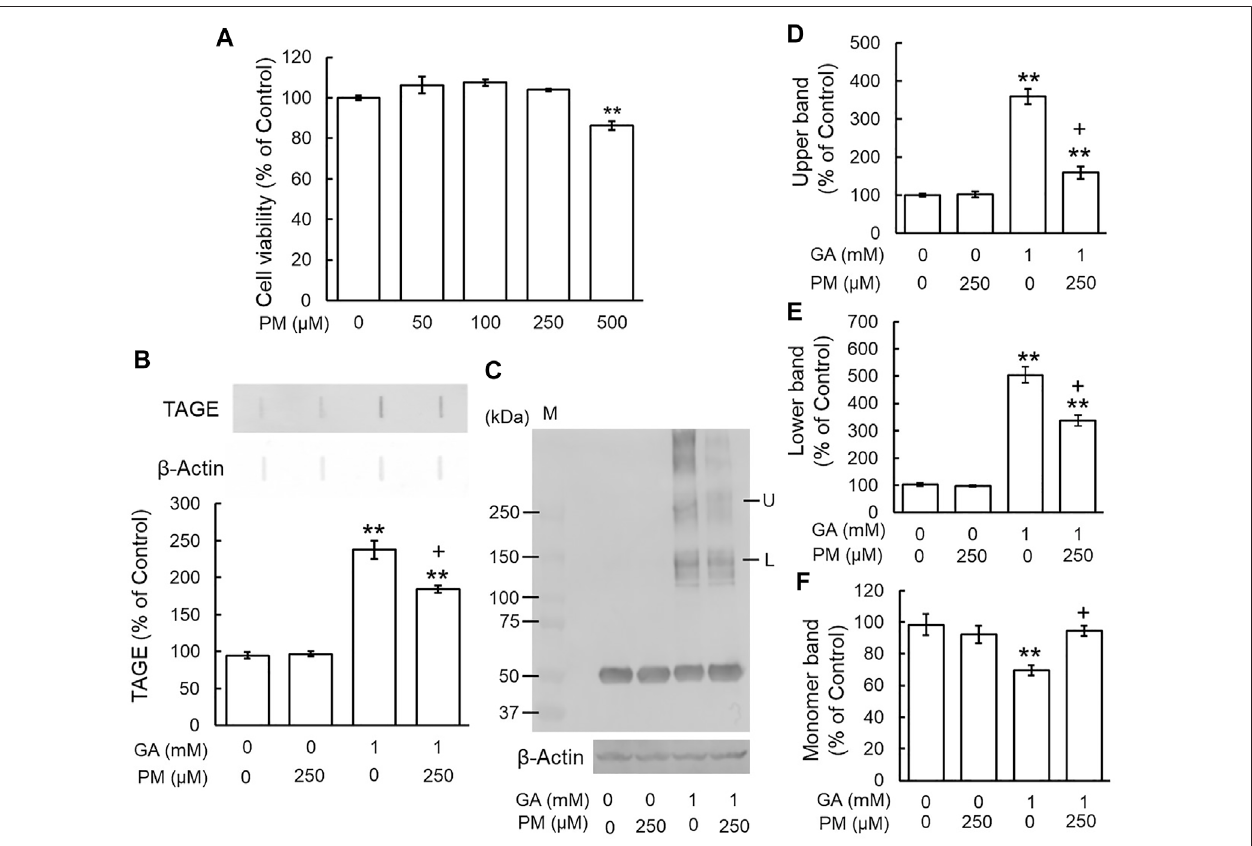
FIGURE 4 | PM inhibited TAGE formation and β -tubulin aggregation by GA. (A) Cell viability following PM treatment. ** p < 0.01 vs. 0 μ M ( n = 6). (B) The levels of TAGE formation determined by slot blot analyses. ** p < 0.01 vs. vehicle control, + p < 0.01 vs. GA alone ( n = 3). (C) The levels of β -tubulin were detected using anti- β - tubulin antibody. M: Marker, L: lower band, U: upper band. (D – F) The levels of upper (D) , lower (E) and monomer (F) bands of the GA-treated β -tubulin. ** p < 0.01 vs. vehicle control, + p < 0.01 vs. GA alone ( n =